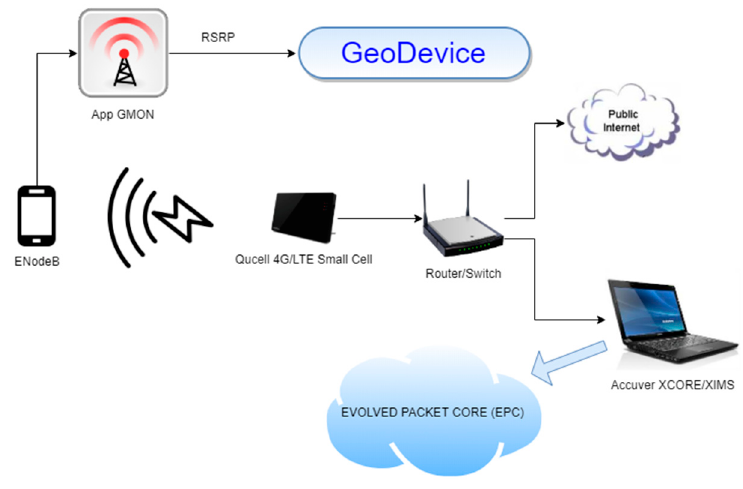
Figure 5. Hardware and software interconnection.